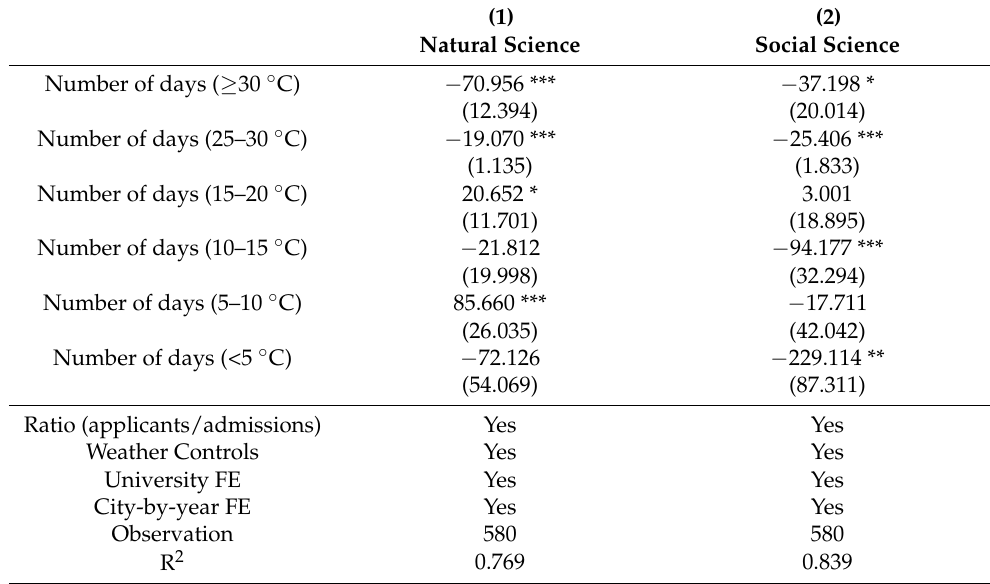
Table 3. Effects of average temperature on the number of applicants: by discipline category.